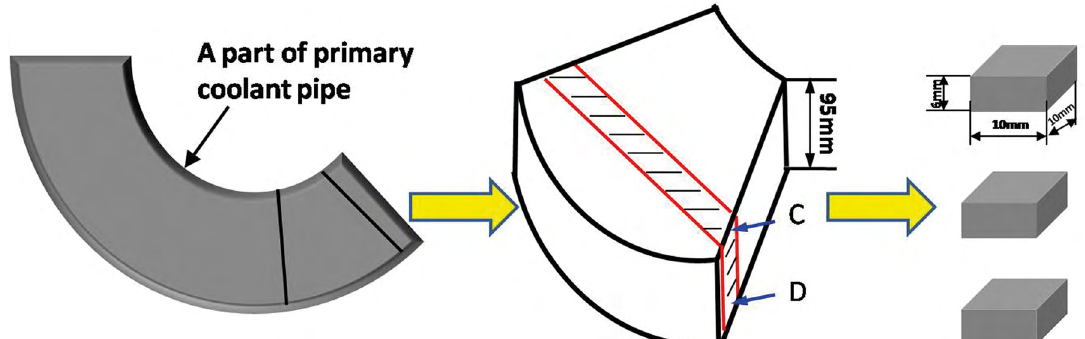
Figure 1. Specimen C and D of Z3CN20.09M CASS cut from the top and bottom of a part of primary coolant